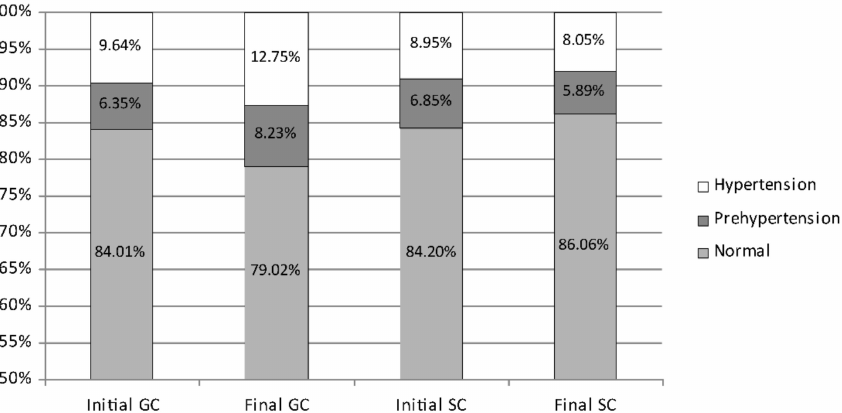
Figure 2. The percentage of girls with systolic prehypertension, hypertension, and normal blood pressure—comparison between the initial and the final measurement sessions. GC—general educa- tion classes (standard PE, 4 h a week); SC—sport classes (elevated PE, 10 h a